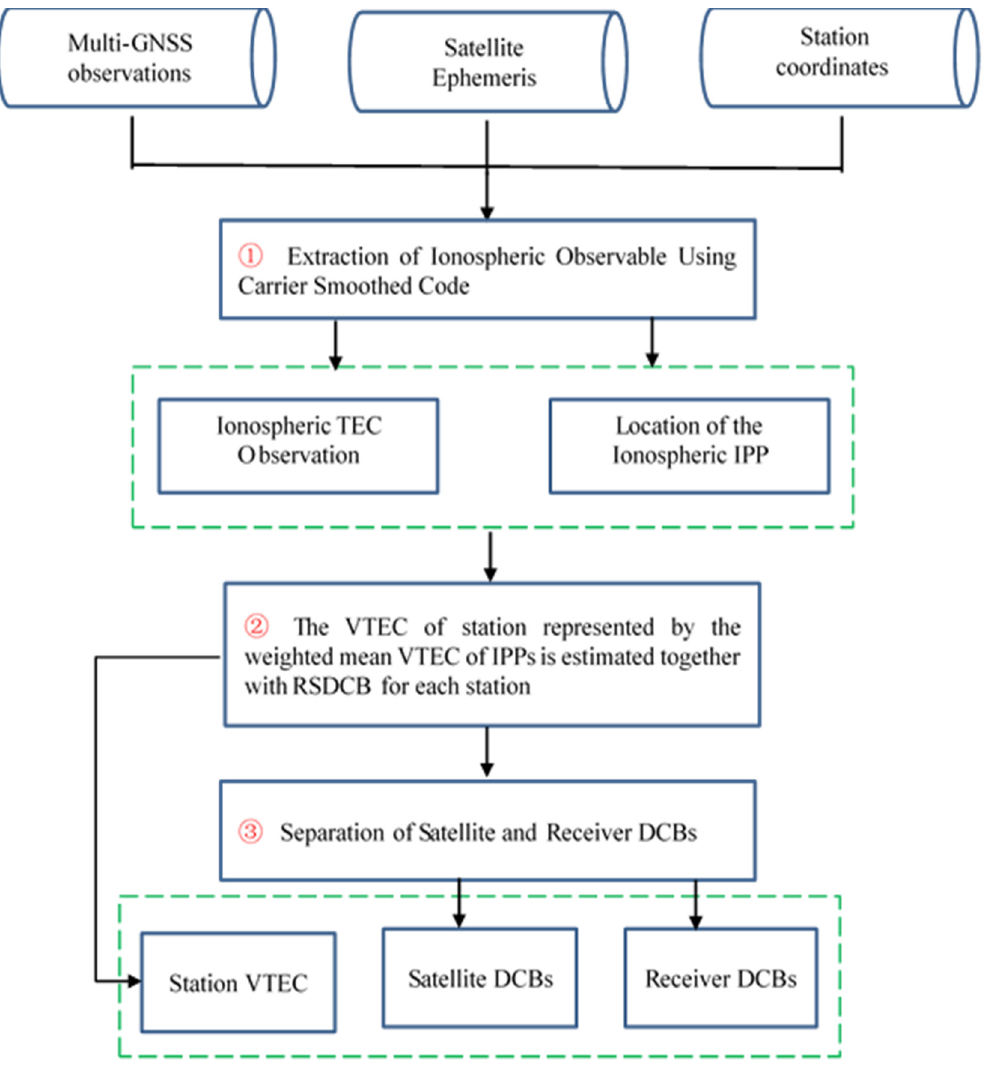
Figure 2. Flowchart of the new method of multi-GNSS DCB estimation.